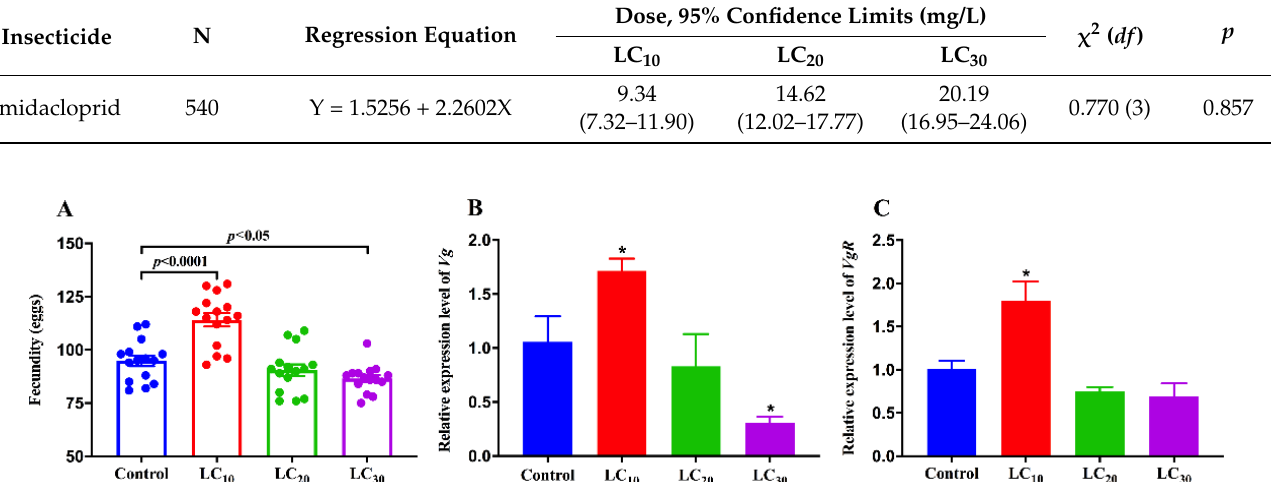
Table 1. Toxicity of imidacloprid on the third instar nymphs of viruliferous SBPH. Insecticide